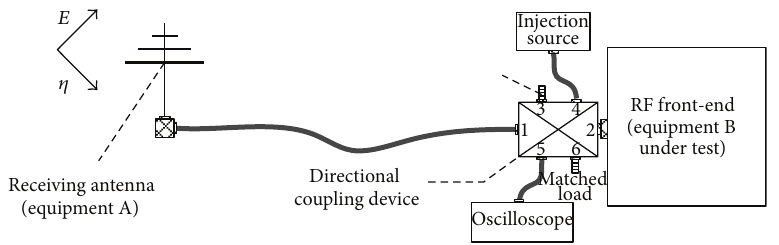
Figure 6: The typical test configuration of SDMCI test method.